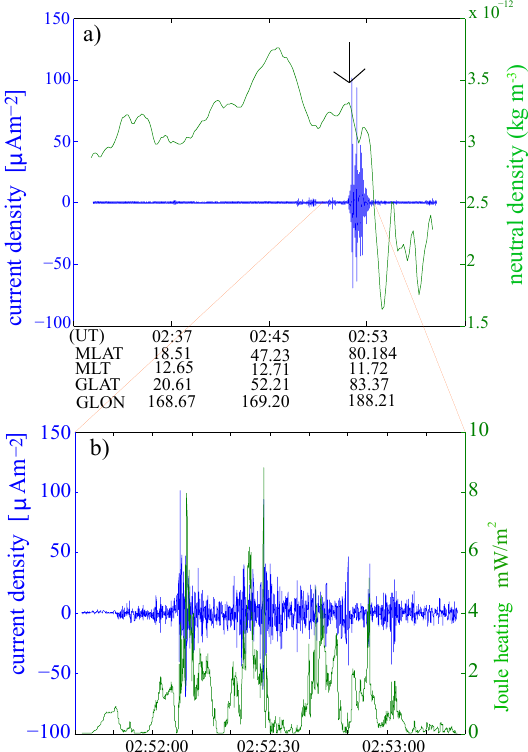
Figure 14. (a) : CHAMP current and neutral density for 9 June 2008, (b) : estimated Joule heating for the E layer on 9 June